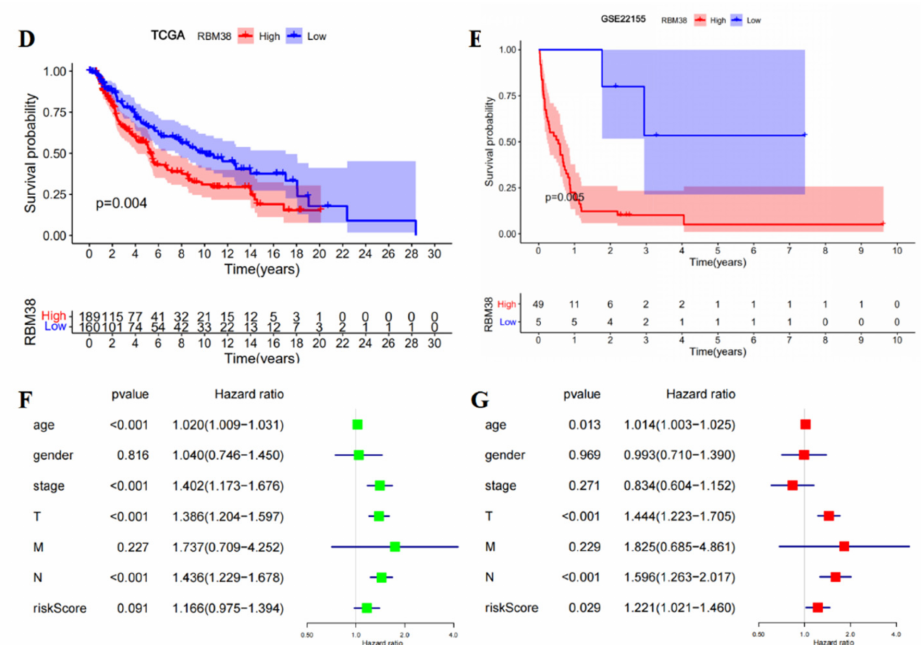
Figure 1. Expression level of RBM38 gene in different tumors and OS in melanoma patients. ( A ) The expression status of the RBM38 gene in various types of cancers in TCGA and GTEx databases. (* p < 0.05; ** p < 0.01; *** p < 0.001). ( B ) For melanoma in the TCGA project, the corresponding normal tissues of the GTEx-skin dataset served as controls. ( C ) RT-qPCR analysis of RBM38 expression of mRNA in 13 pairs of melanoma tissues and matched normal tissues quantified after transfection. (Data are shown as the mean ± SD of three replicates. *** p < 0.001 by ANOVA test). ( D , E ) The TCGA samples with entire survival and clinical information and the GSE22155 samples were used to analyze the survival of RBM38. ( F , G ) Univariate and multivariate Cox analyses of the expression of RBM38 and clinicopathological parameters in the TCGA group with complete survival and clinical